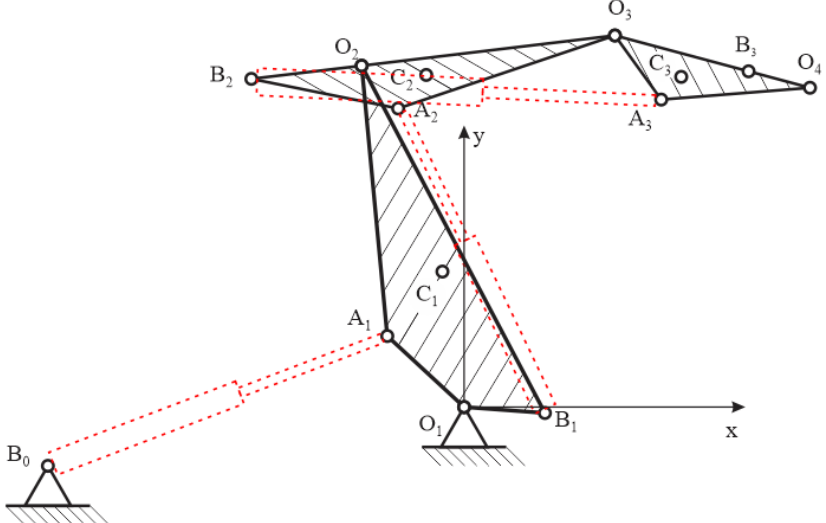
Figure 3. Schematic representation of the robotic arm with the connection points and the association of this structure with some hydraulic cylinders. B , vertical displacement is measured using a laser displacement sensor. At point 3